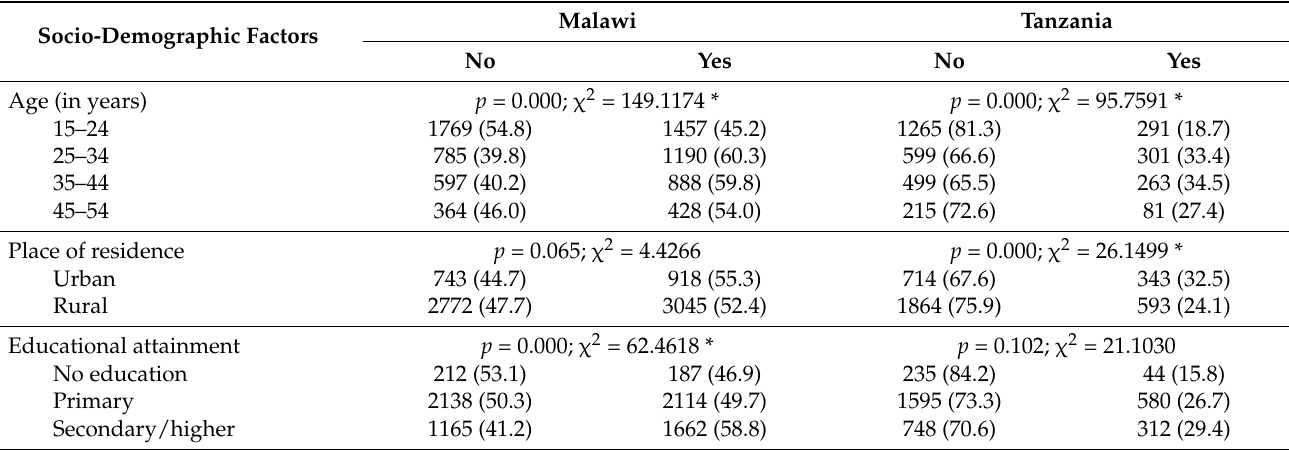
Table 3. Bi-variate analysis of male involvement in FP decisions in Malawi and Table 3. Bi ‐ variate analysis of male involvement in FP decisions in Malawi and Tanzania.